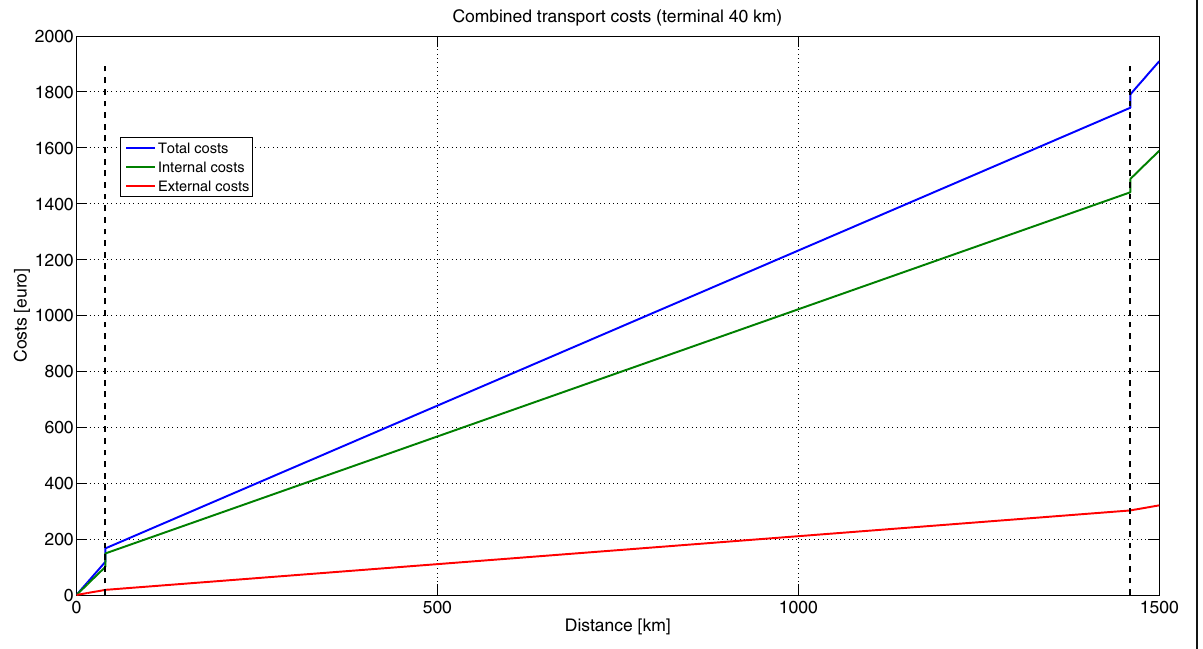
Fig. 6 Combined transport costs with pre- and post-haulage equal to 40 km (related to the transport of one standard ITU 40 ′ )